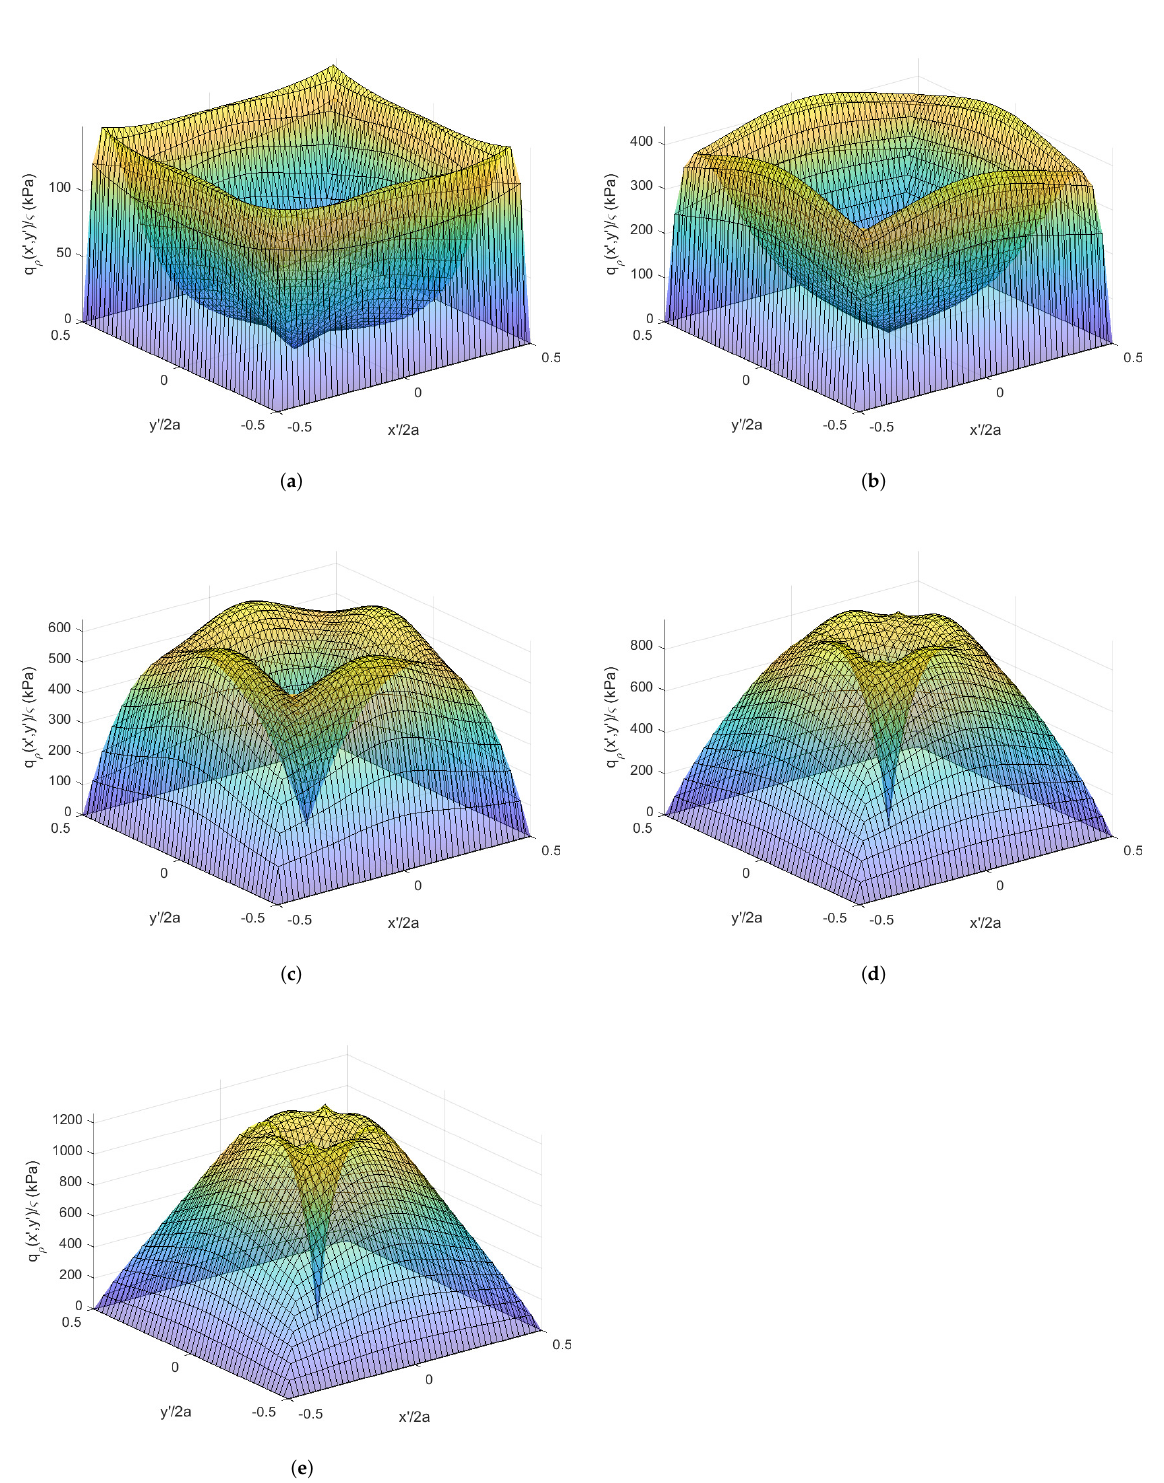
Figure 10. Radial shear traction surface examples from Equation (2) mapped to a square area. Subplots ( a – e ) correspond to normal loading cases N1–N5, respectively; the shear traction distributions are normalized by the peak traction ratio ς